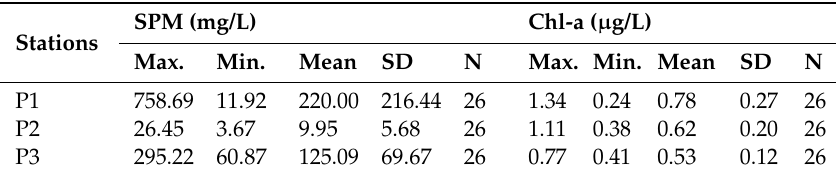
Table 1. Statistics of SPM and Chl-a concentration measured at Stations P1, P2 and P3. “Max.”, “Min.”, and “SD“ stand for maximum, minimum and standard deviation, respectively, and “N” is the number of samples.